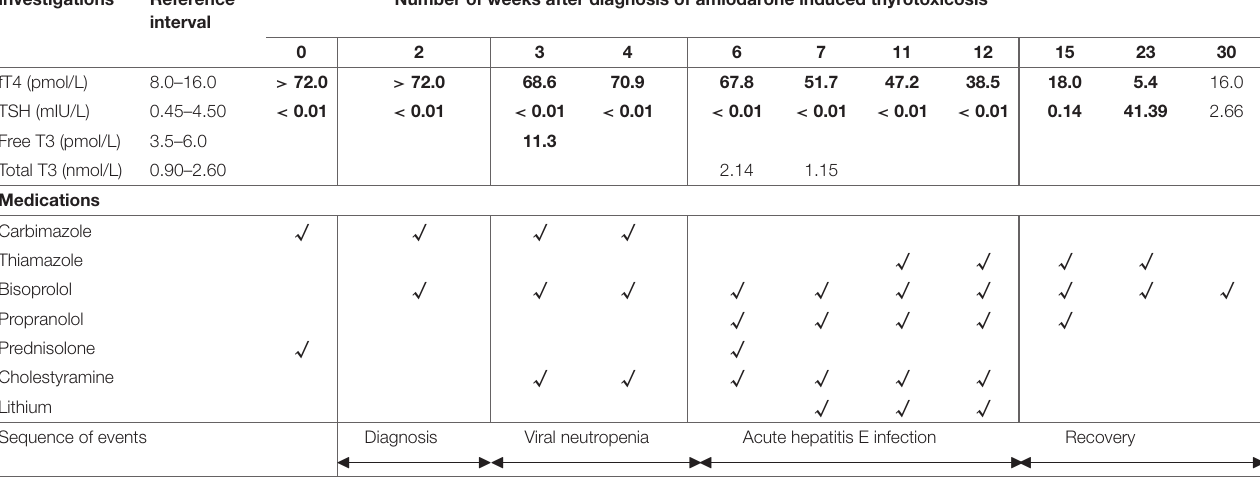
TABLE 2 | Summary of clinical course with corresponding treatment.